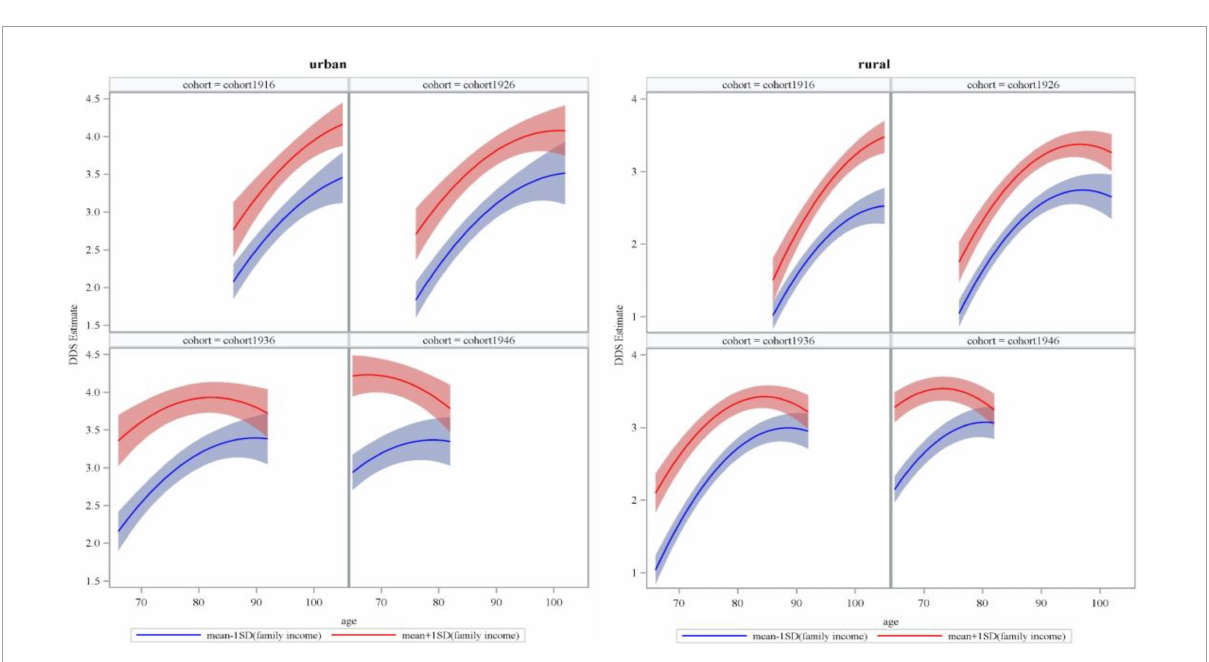
FIGURE3 Estimated dietary diversity score (DDS) of family income with age and across successive cohorts in urban and rural older adults.